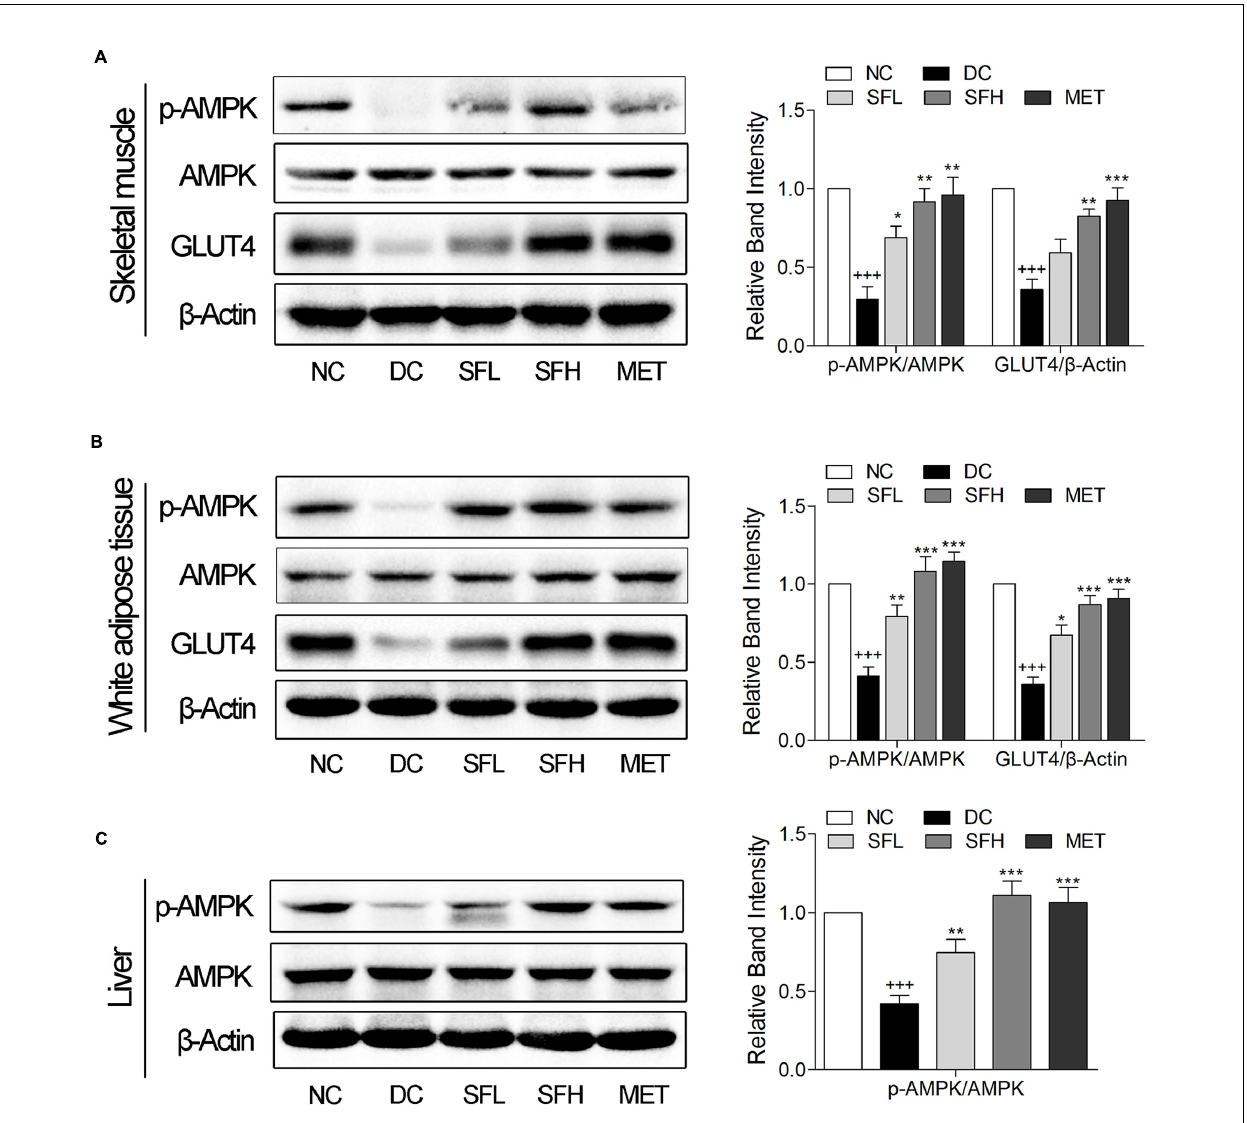
FIGURE 5 | SD-FRE enhanced GLUT4 expression, activated AMPK phosphorylation in insulin target tissues. Western blot analysis of AMPK phosphorylation, GLUT4 expression in skeletal muscle (A) and WAT (B) of KK-Ay mice. (C) Western blot analysis of AMPK phosphorylation in liver of KK-Ay mice. Data are mean ± SEM, shown as relative band intensity compared with NC group ( n = 3). +++ p < 0.01 vs. NC group, ∗ p < 0.05, ∗∗ p < 0.01, ∗∗∗ p < 0.001 vs. DC